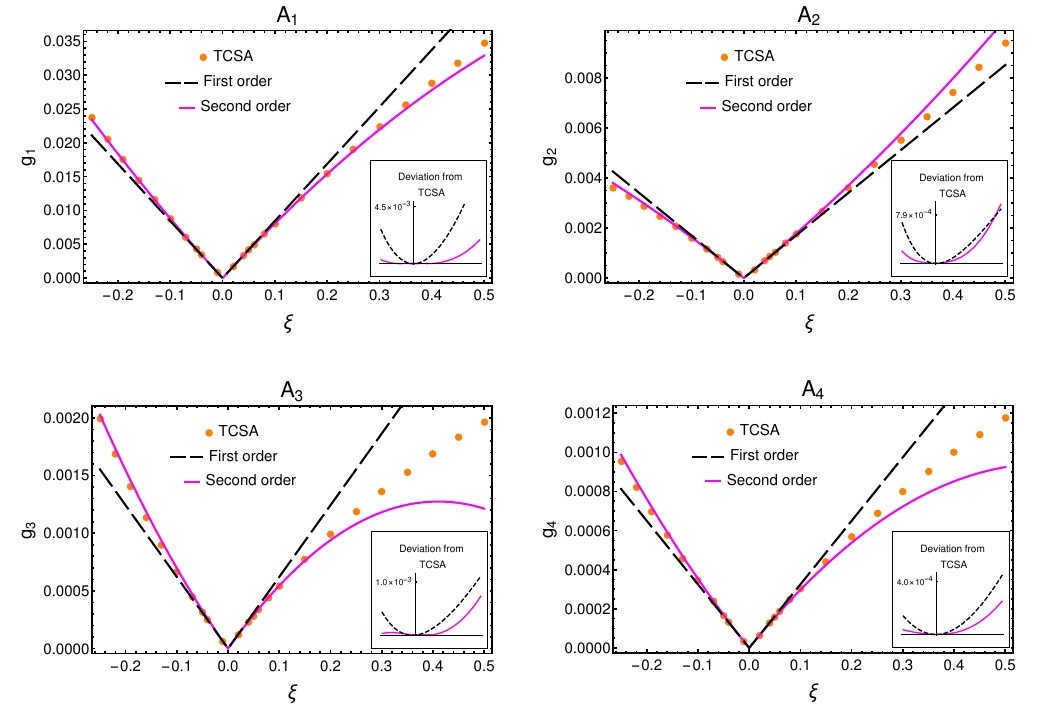
Figure 1 . Comparison between TCSA and perturbative overlaps of the lowest-lying four one- particle states as functions of the quench magnitude (cid:24) = ( h f (cid:0) h i ) =h f for quenches along the E 8 axis in volume m 1 R = 40. Dashed lines indicate the (cid:12)rst-order predictions, and continuous lines depict the sum of (cid:12)rst two orders. TCSA data is shown by dots. The insets show the deviations of the (cid:12)rst and second order results from the numerical